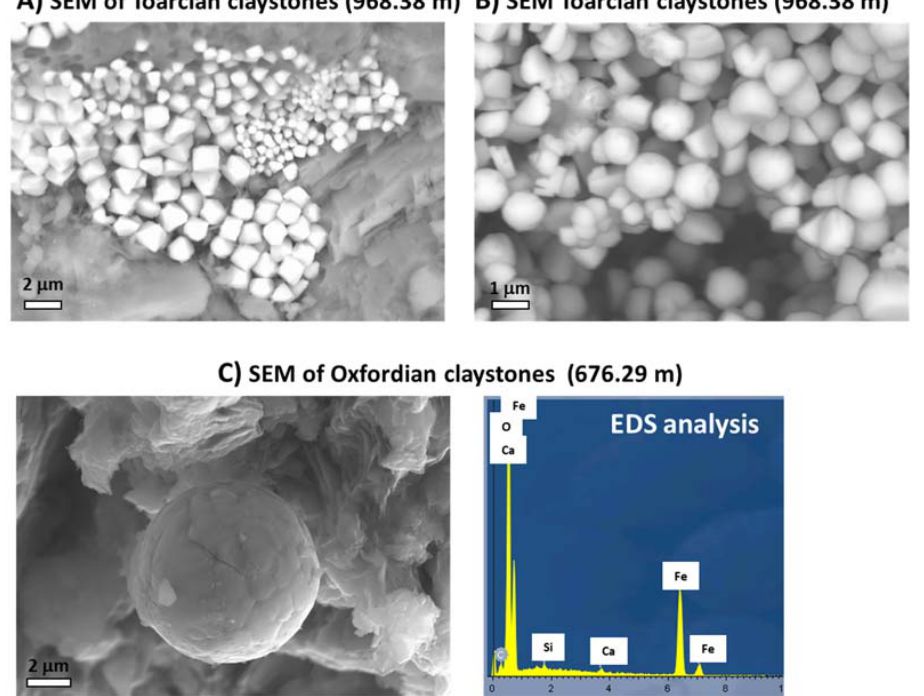
Figure 8. Scanning electron microscopy (SEM) observation of shales from Borehole EST433. Fram- boids of pyrite ( A ) and partially oxidized pyrite ( B ) observed in Toarcian claystones. ( C ) Spherule of former pyrite framboids oxidized observed in Oxfordian claystones and the EDS analysis.